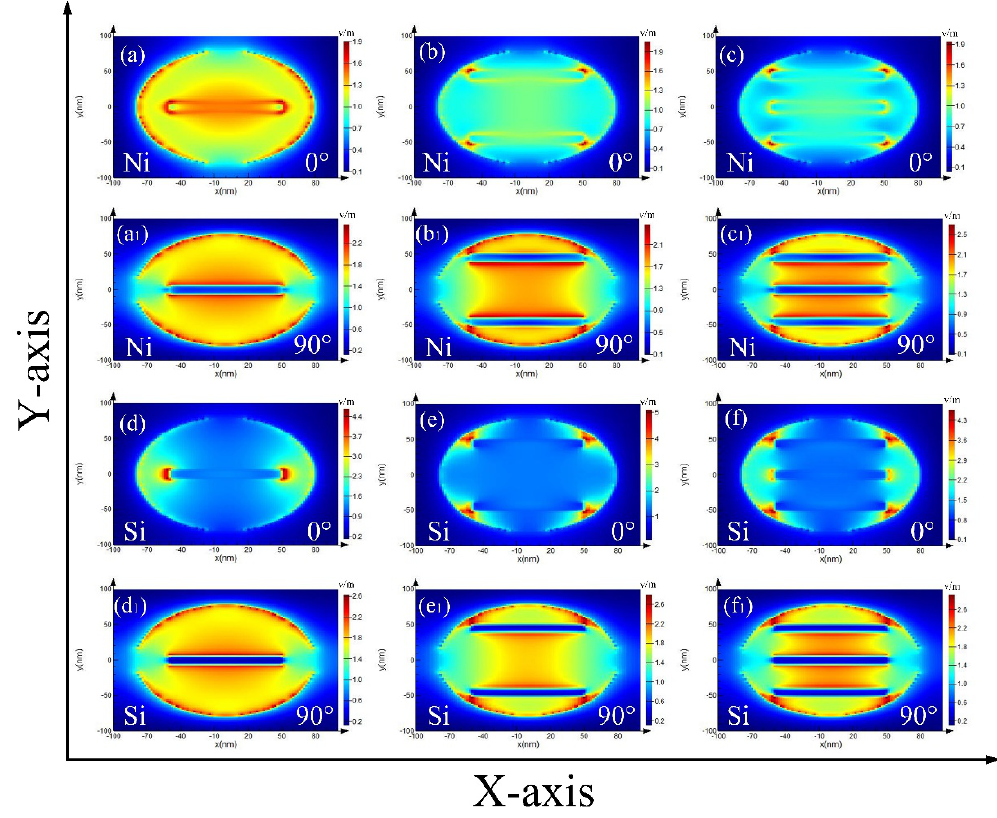
Figure 6. The relative electric field distribution diagrams in the cases of different materials and the number of material strips. ( a – c ) is Ni; ( d – f ) is Si. When there is subscript, the polarization direction is 90°.